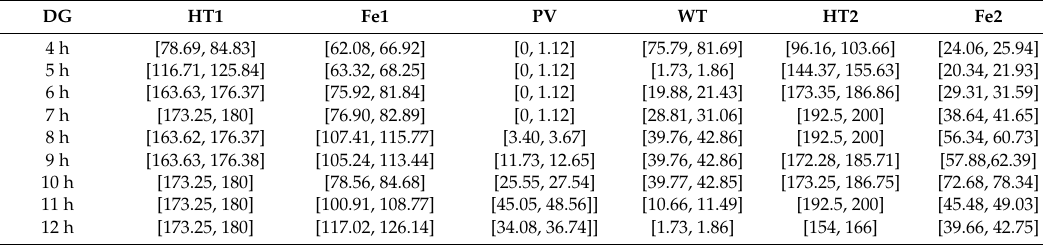
Table 3. Prediction values of hours considering prediction error in a typical day.